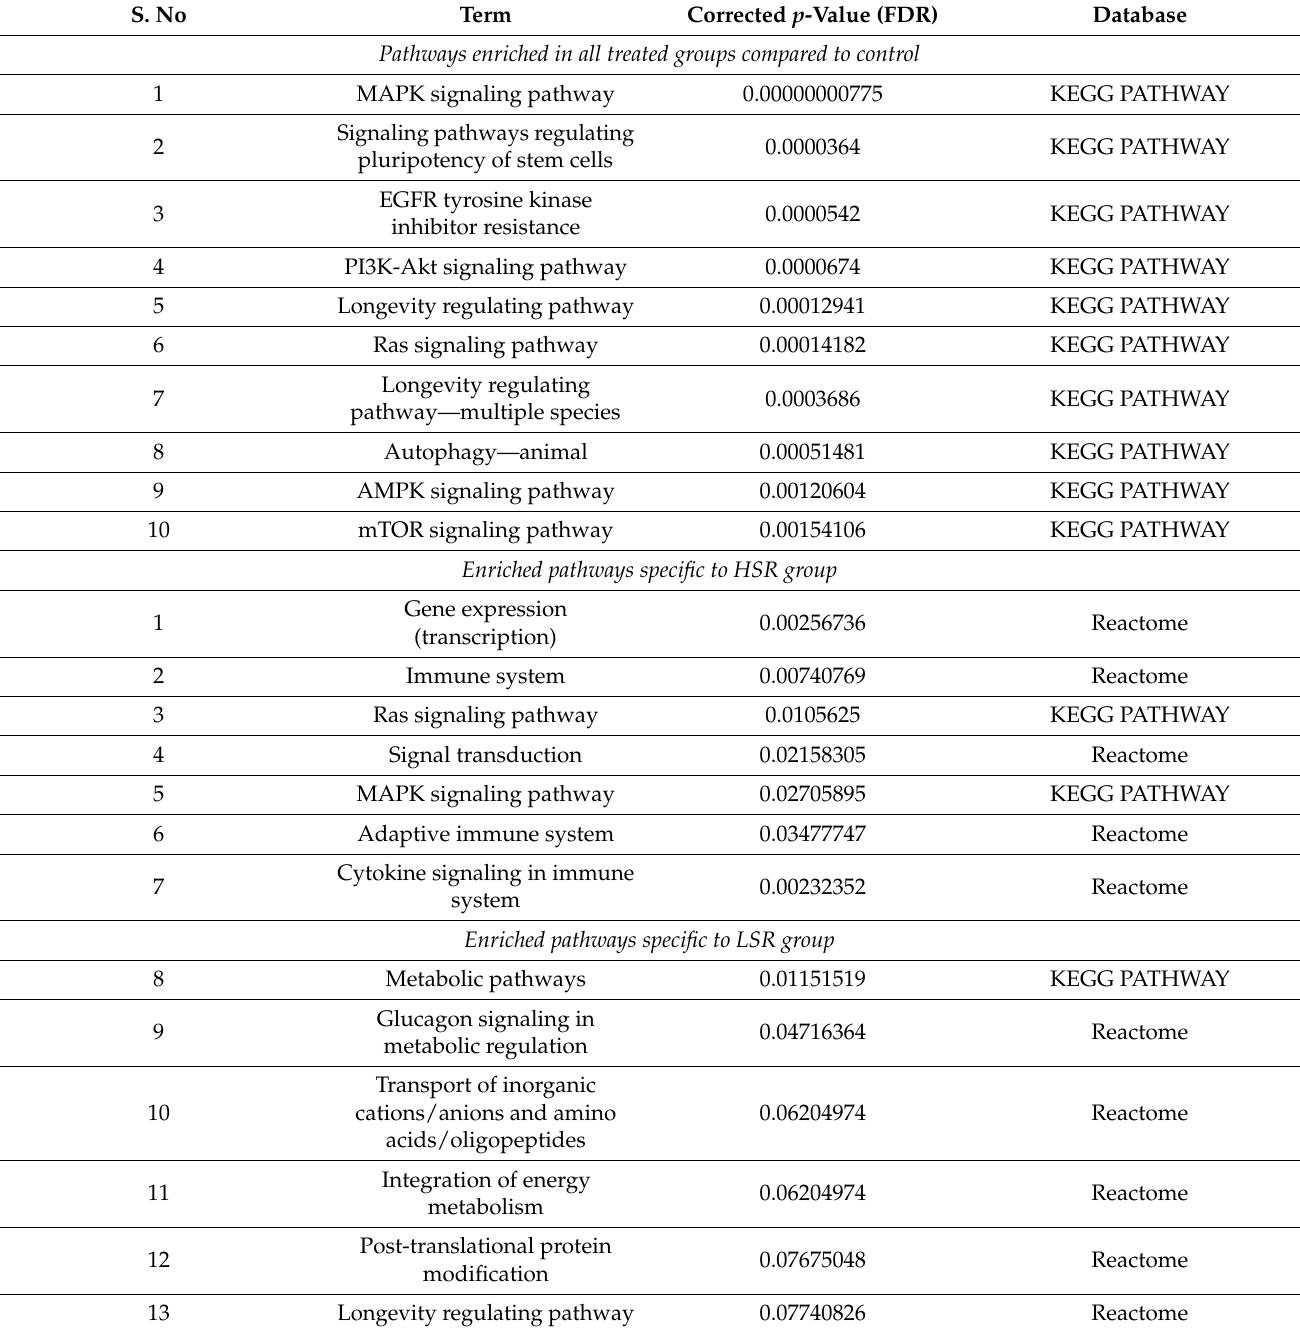
Table 3. List of top enriched LPS-induced pathways identified in lambs (treated vs. control) and within HSR and LSR